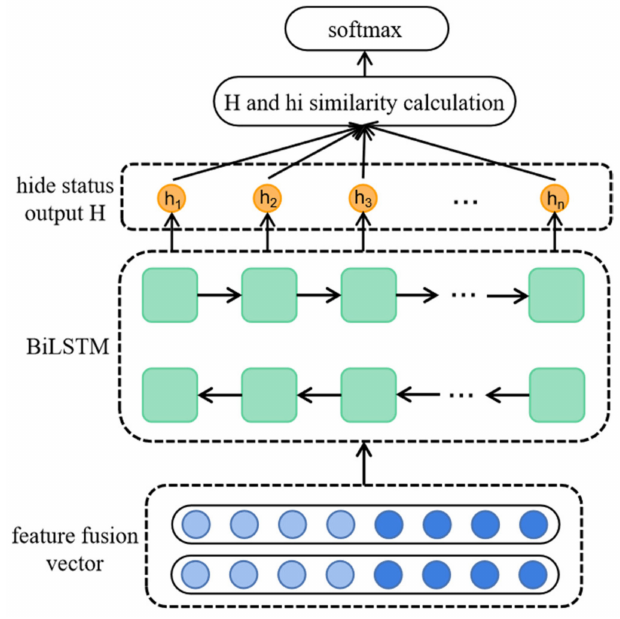
Figure 3. Structure of BiLSTM-Self-Attention